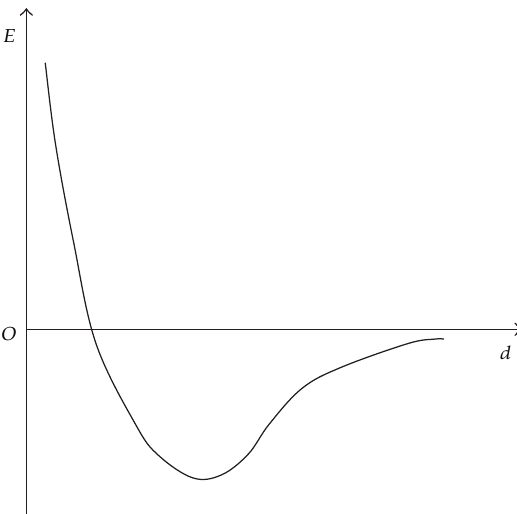
Figure 1: The atom-atom interaction potential energy as a function of the average distance between particles.